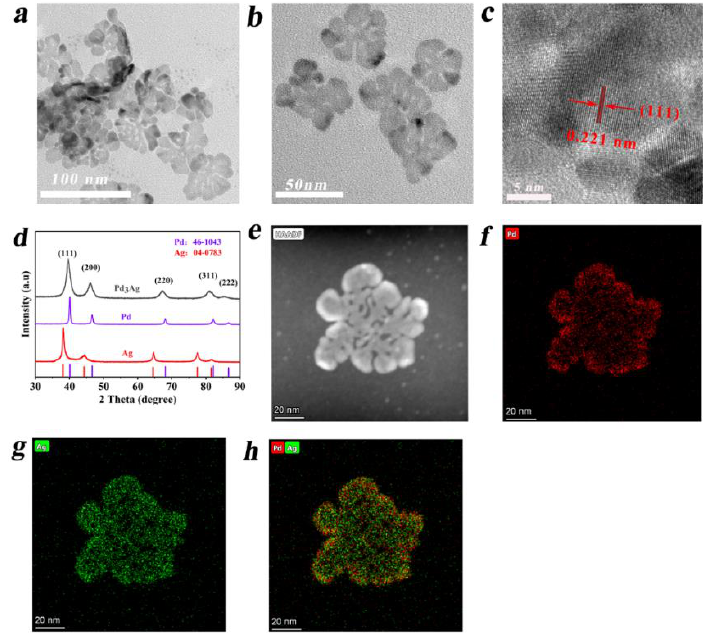
Figure 1. Structural characterizations of Pd 3 Ag nanosheets: ( a , b ) low-resolution TEM images; ( c ) high-resolution TEM images; ( d ) XRD patterns of Pd 3 Ag; ( e ) HADDF-STEM-EDS mapping of Pd and Ag in the selected area; ( f ) elemental mapping of Pd; ( g ) elemental mapping; ( h ) mixed pattern of Pd and Ag.